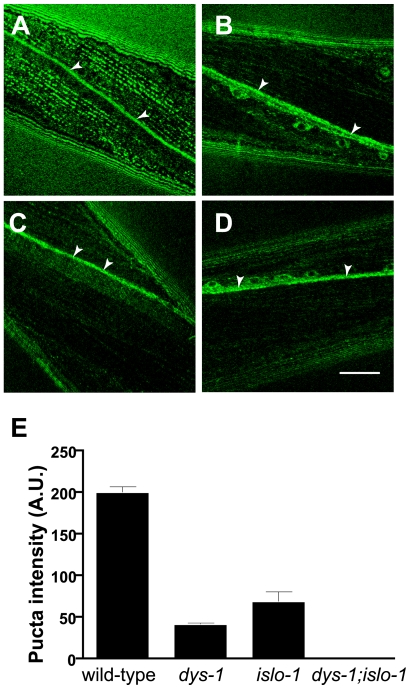
The dystrophin complex is necessary for localization of the SLO-1 channel in muscles, but not in neurons.(A–D) The localization of SLO-1::GFP in wild-type (A), dys-1 (B), islo-1 (C), and islo-1;dys-1 (D). The same integrated array, SLO-1::GFP, was used for this analysis in different genetic backgrounds. To make the expression level of SLO-1::GFP close to in vivo, we introduced a slo-1 loss-of-function mutation to all of strains used in this experiment. Arrowheads indicate SLO-1::GFP localized in neurons. Scale bar, 10 µm. (E) The quantification analysis of puncta intensity in muscle membrane. The intensity of puncta was analyzed as described in Materials and Methods. At least 50 animals from each genotype were observed. Error bars, SEM. P values (unpaired T test) for comparison between the wild-type animal group and other animal groups are below 0.001.